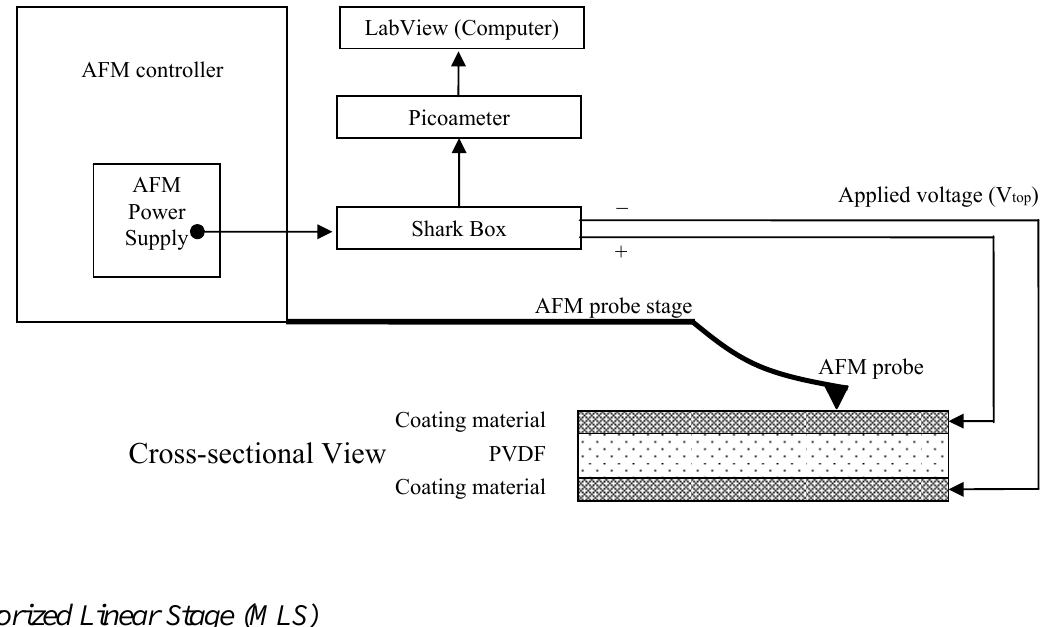
Figure 1. Diagram for the experimental setup and characterization. This work was done with a Si3N4 probes. The external electrical potentials were supplied to the PVDF samples throughout the shark box which is a splitter for electrical potentials and current.